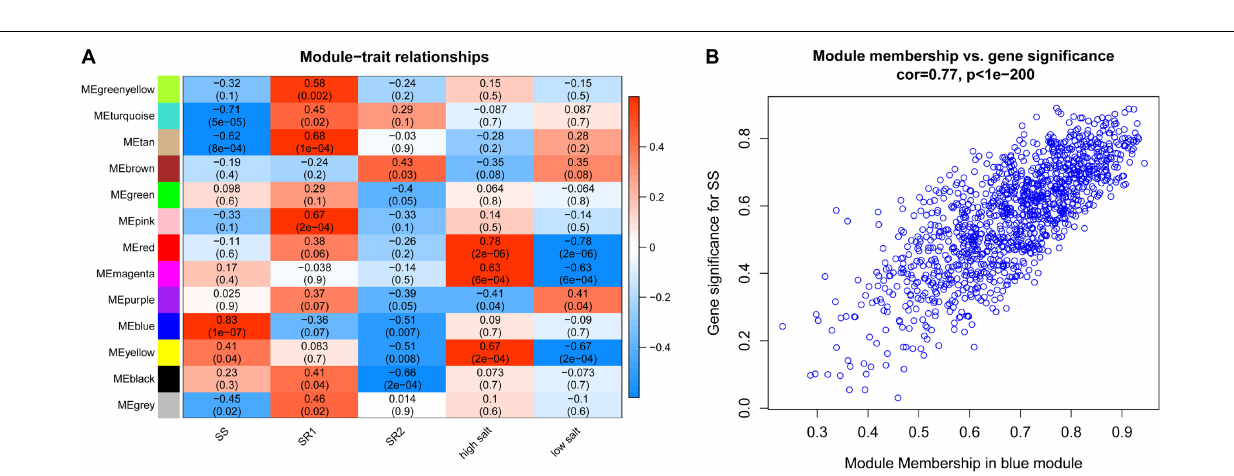
Frontiers in Genetics |